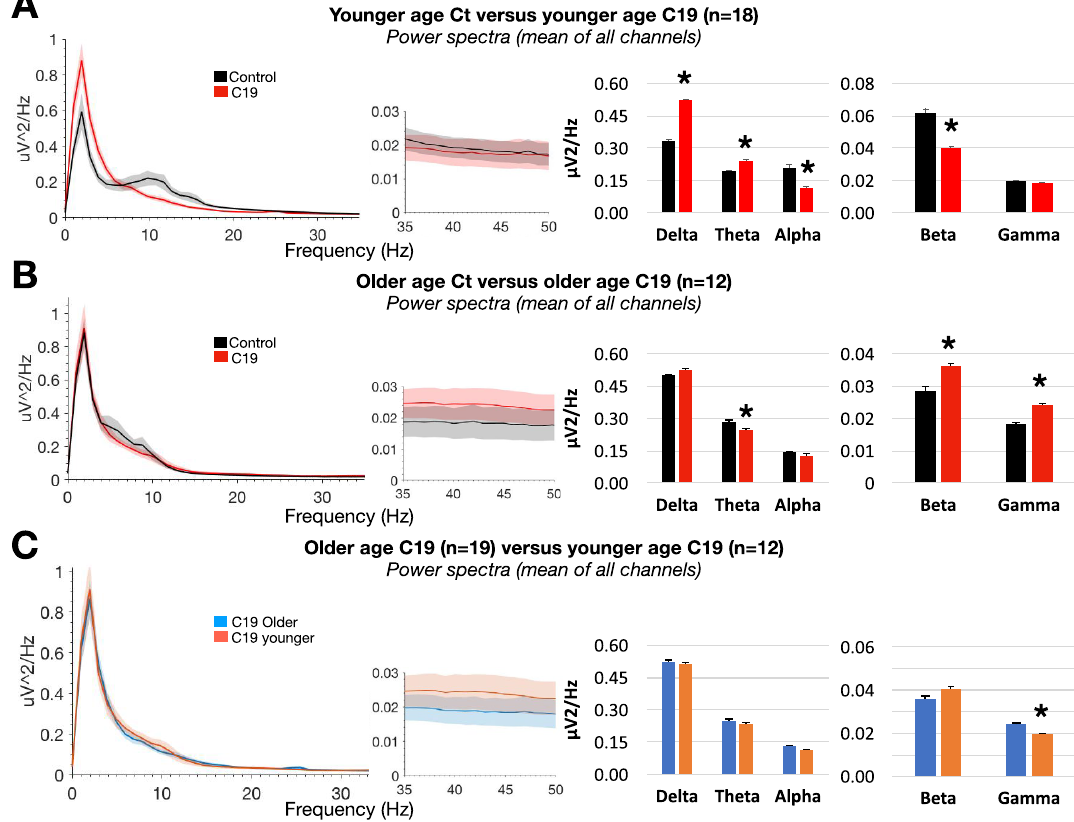
Figure 4. ( A ) Power spectral density (mean of 16 EEG channels) in age below 70 (younger) control and age below 70 (younger) C19 subjects (n = 18 per group). Histograms show power in individual frequency bands. ( B ) Same as ( A ) for age above 70 (older) control and age above 70 (older) C19 subjects (n = 12 per group). ( C ) Same as ( A – B ) for age above 70 (older) C19 subjects (n = 19) and age below 70 (younger) C19 subjects (n = 12). Age- matched Ct Younger Ct Older Ct versus C19 versus C19 versus